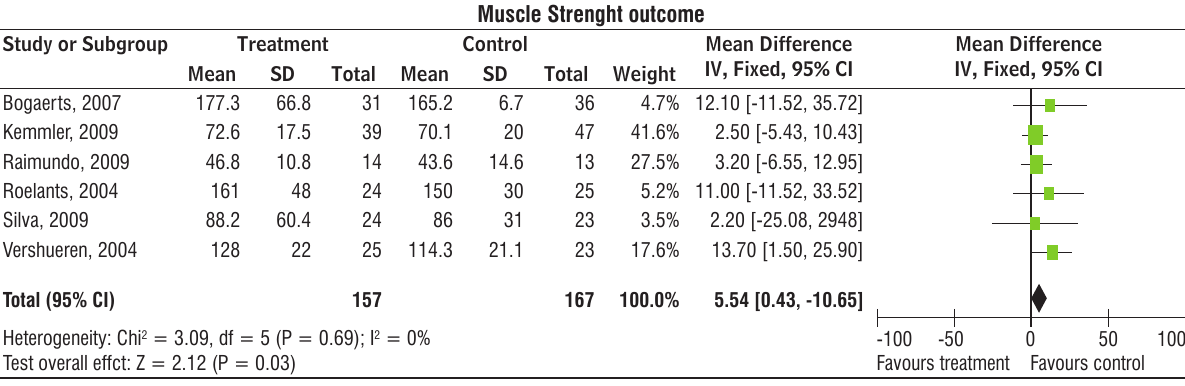
Figure 3 - Forest Plot studies of meta-analysis for muscle strength outcome.